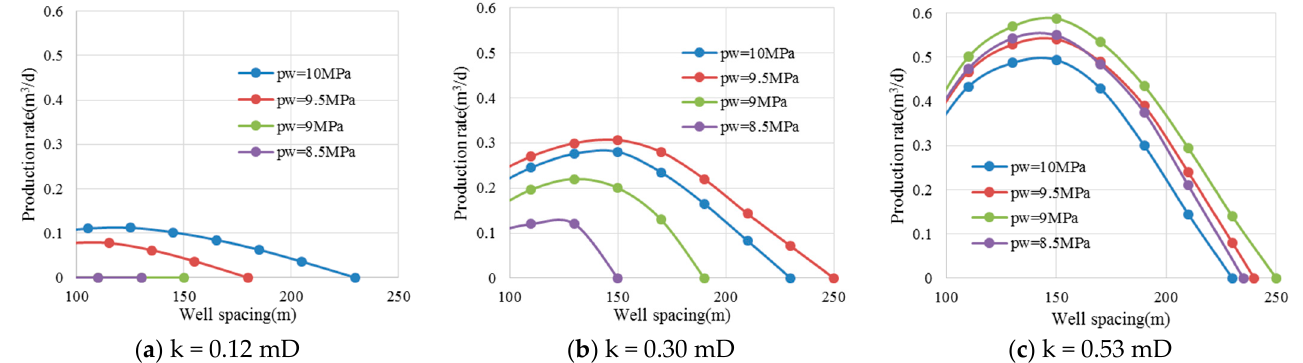
Figure 18. The relationship between the production rate and the well spacing before fracturing.